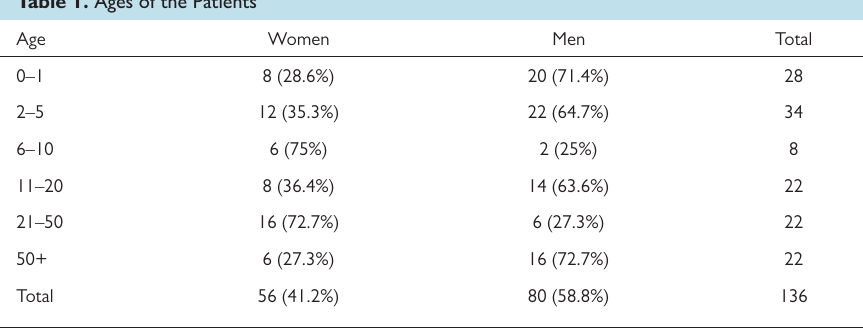
Table 1. Ages of the Patients